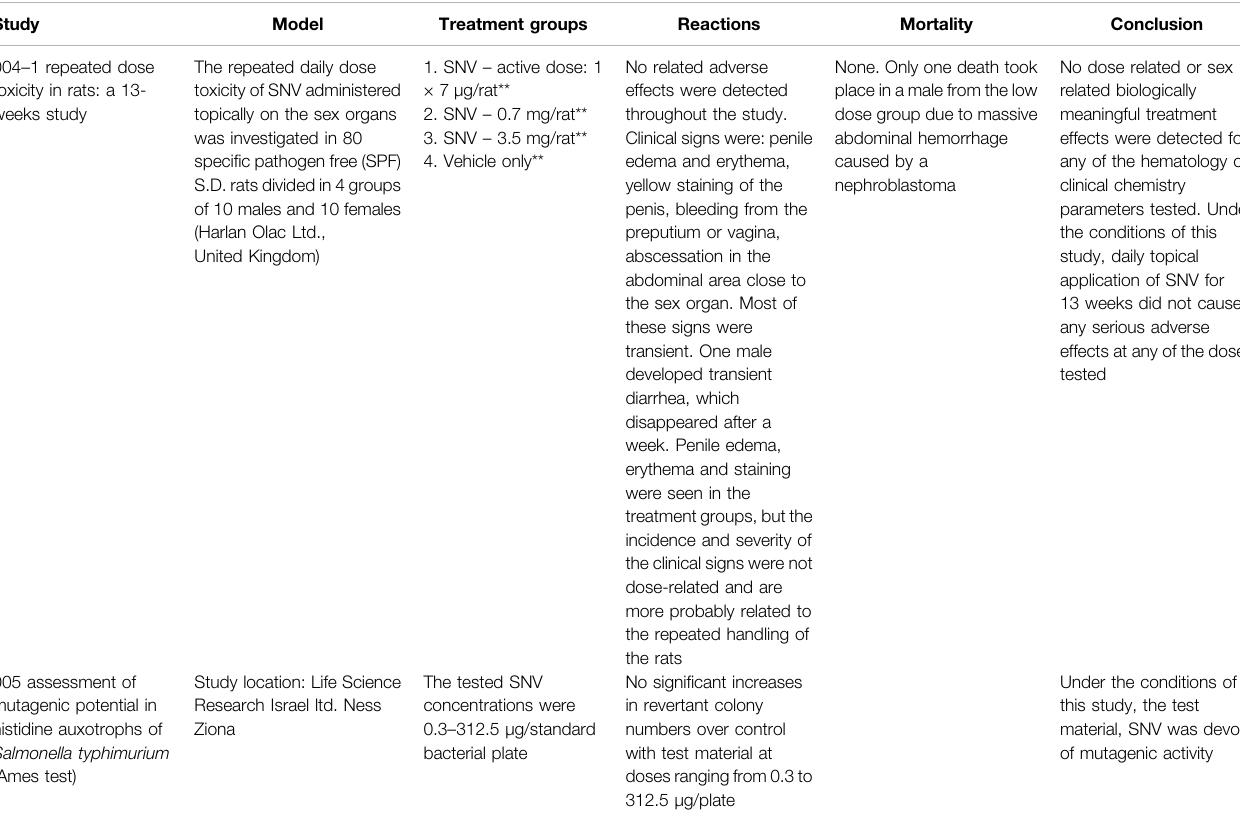
Frontiers in Pharmacology |